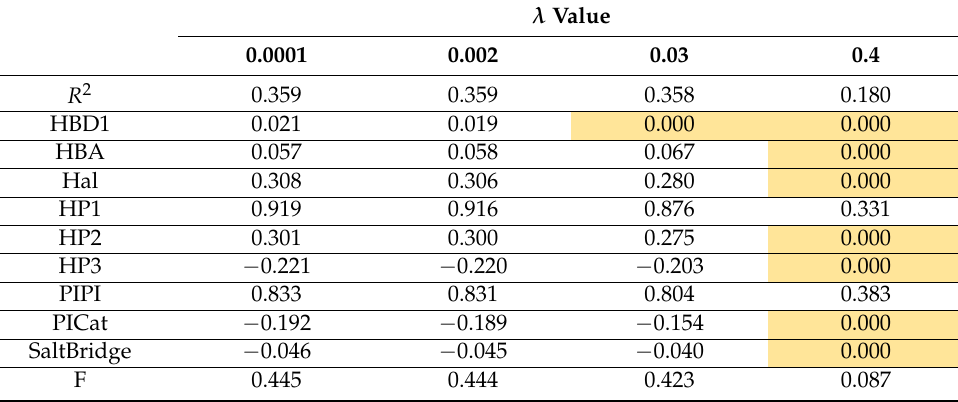
Table 4. Dependence of the Free-Wilson regression coefficients on the λ regularization parameter